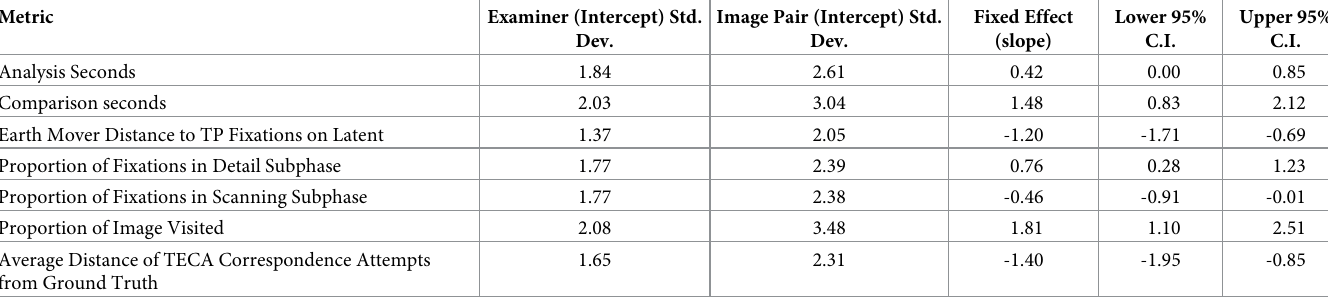
Table 1. Fixed effect values and 95% confidence intervals (C.I.) for selected metrics of interest. Metric Examiner (Intercept) Std.